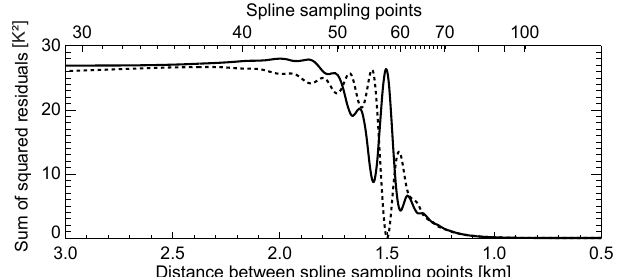
Figure 3. This figure shows the differences between the spline and the approximated test data (solid line: phase of 0, dashed line: phase of π/ 2) which are summed up between 20 and 40km. They are plotted against the distance between the number of spline sampling points and/or the distance between spline sampling points. The number of spline sampling points and/or distance between spline sampling points refers to the whole height range between 15 and 100km.